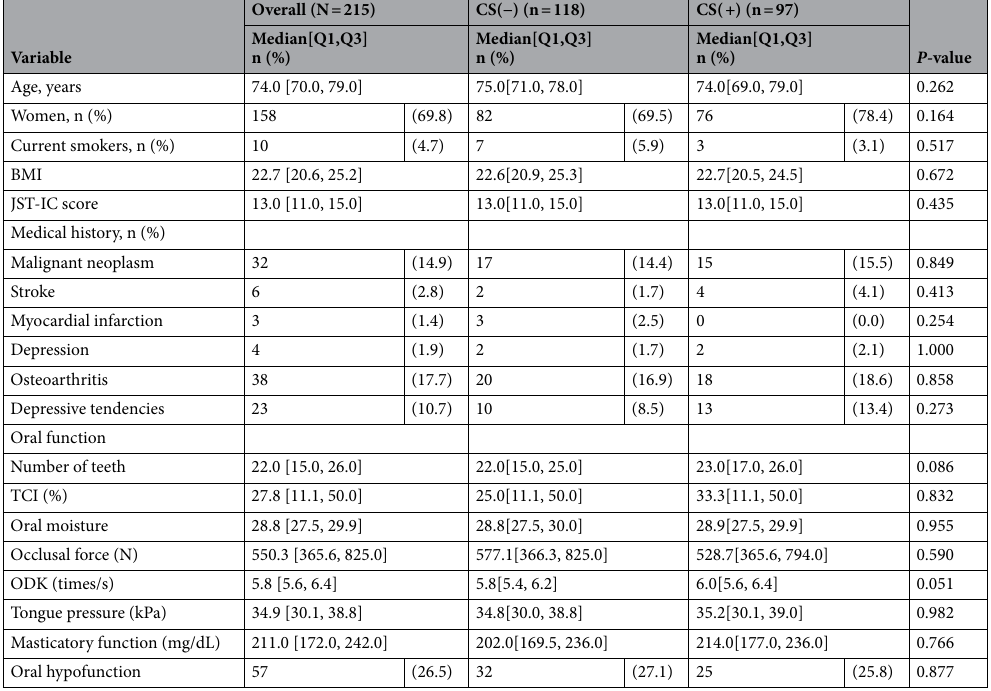
Table 1. Comparisons between the two groups with and without COVID-19-related stress. Categorical variables are shown as numbers (percentages) and were analyzed by performing either the chi-square test or Fisher’s exact test. Continuous variables are expressed as median [Q1, Q3], and were analyzed by performing the Mann–Whitney U test. P -values < 0.05 were considered statistically significant. Abbreviations: BMI body mass index; CS COVID-19-related stress; JST-IC Japan Science and Technology Agency Index of Competence; ODK oral diadochokinesis; Q1 , first quartile; Q3 third quartile ; TCI tongue coating